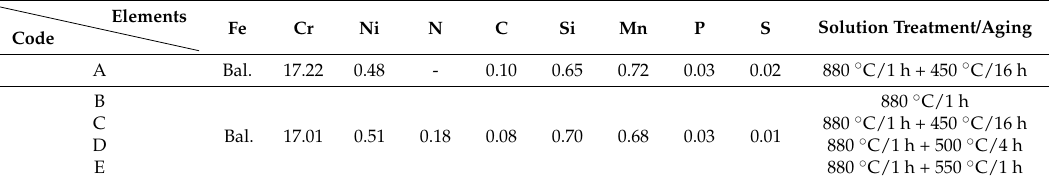
Table 1. Chemical compositions (mass %) of 430 stainless steels used in the present study and the conditions of heat